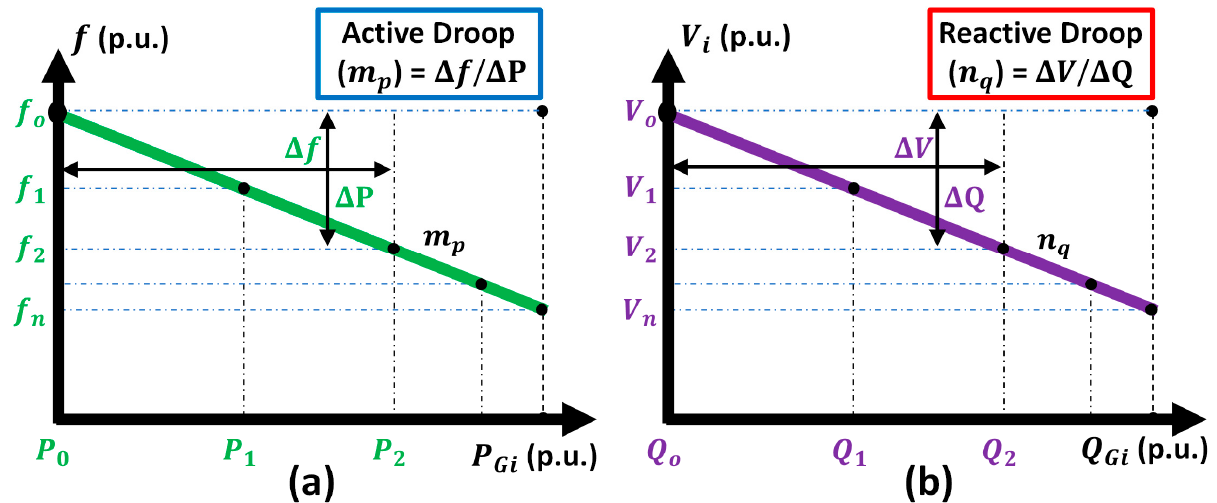
Figure 2. Droop curves for generating units: ( a ) 𝑃 - 𝑓 droop, ( b ) 𝑄 - 𝑉 droop.